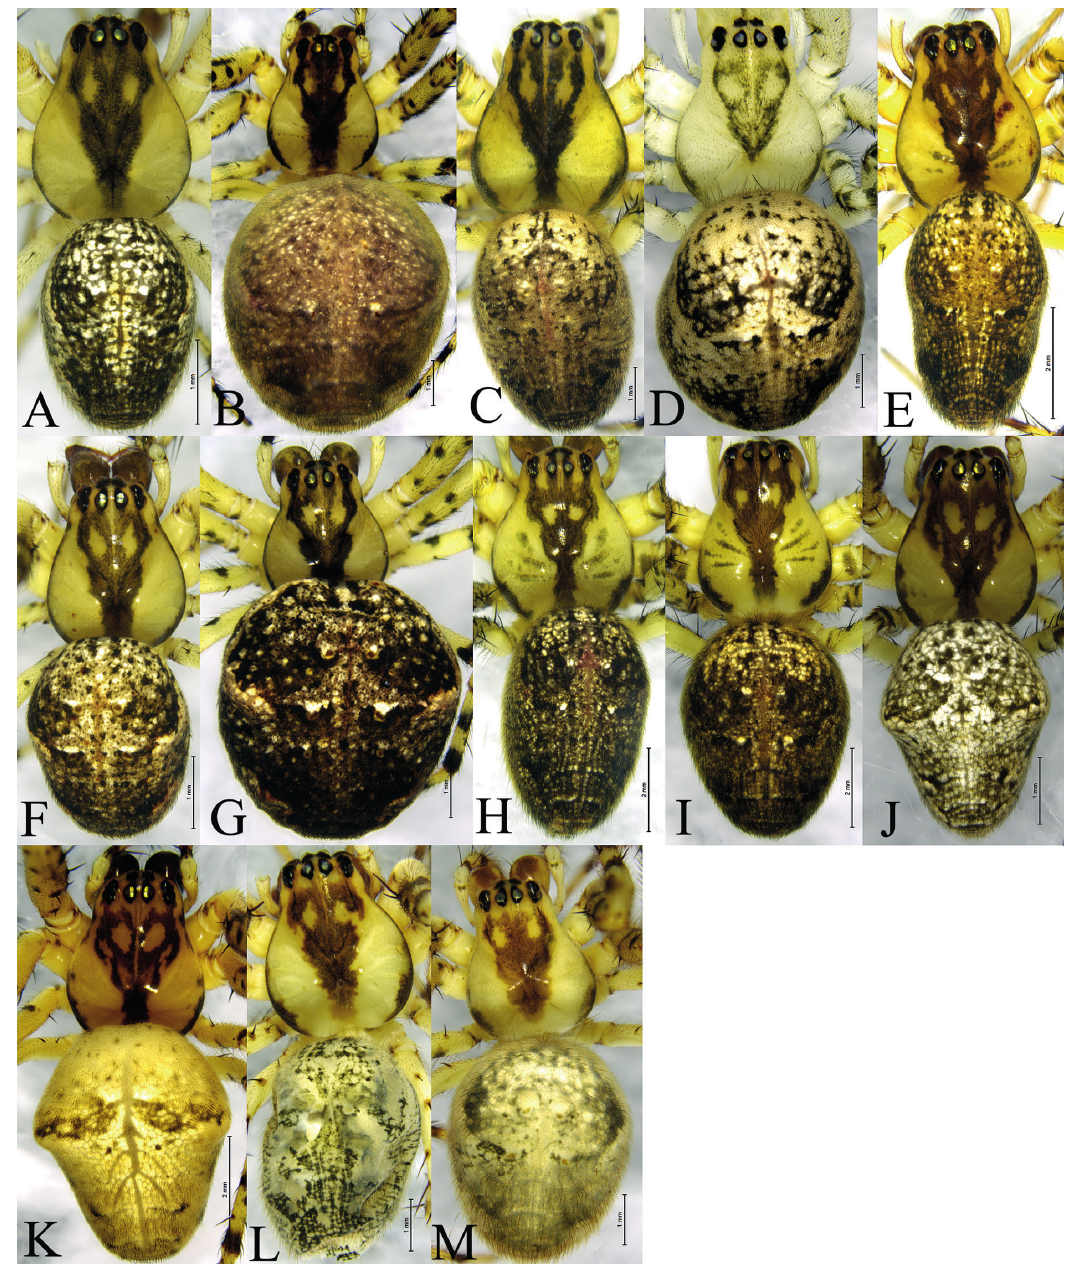
Fig. 1. A . Meta bowo sp. nov., ♂, holotype (SWUC-T-TEg-02-01), habitus, dorsal view. B . Meta bowo sp. nov., ♀, paratype (SWUC-T-TEg-02-06), habitus, dorsal view. C . Meta cona sp. nov., ♂, holotype (SWUC-T-TEg-03-01), habitus, dorsal view. D . Meta cona sp. nov., ♀, paratype (SWUC-T-TEg-03-02), habitus, dorsal view. E . Meta gyirong sp. nov., ♂, holotype (SWUC-T-TEg-04-01), habitus, dorsal view. F . Meta hongyuan sp. nov., ♂, holotype (SWUC-T-TEg-05-01), habitus, dorsal view. G . Meta hongyuan sp. nov., ♀, paratype (SWUC-T-TEg-05-03), habitus, dorsal view. H . Meta tibet sp. nov., ♂, holotype (SWUC-T-TEg-06-01), habitus, dorsal view. I . Meta tibet sp. nov., ♀, paratype (SWUC-T-TEg-06-05), habitus, dorsal view. J . Meta wanglang sp. nov., ♂, holotype (SWUC-T-TEg-07-01), habitus, dorsal view. K . Meta wanglang sp. nov., ♀, paratype (SWUC-T-TEg-07-03), habitus, dorsal view. L . Meta weining sp. nov., ♂, holotype (SWUC-T-TEg-08-01), habitus, dorsal view. M . Meta weining sp. nov., ♀, paratype (SWUC-T-TEg-08-03), habitus, dorsal